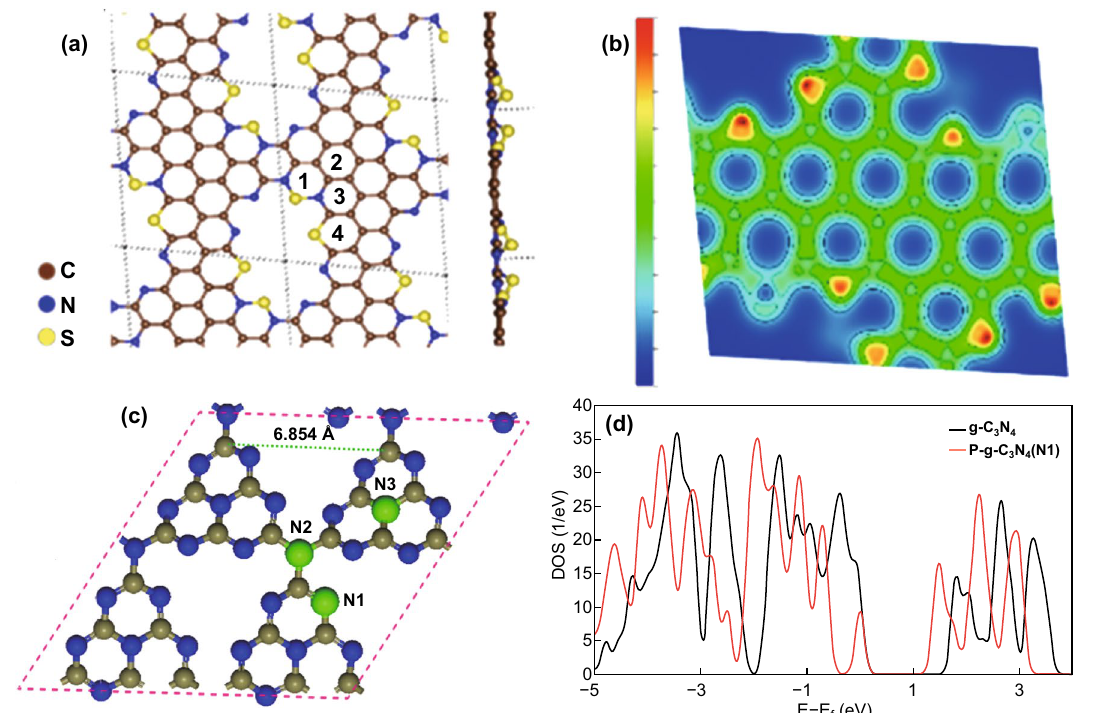
Fig. 5 a Optimized atomic structure of S-doped mesoporous CN (S-MCN). b Charge density profile of S-MCN, blue color—lowest electron density (0%), and red color—highest electron density (100%). Reproduced with permission from Ref. [31]. c Optimized structure g-C 3 N 4 mon- olayer, showing possible P-doping sites. d DOS plots of P-doped g-C 3 N 4 for P substitution at N1 and N2 sites. Reproduced with permission from Ref. [32]. Copyright permissions from American Chemical Society and Springer Nature. (Color figure